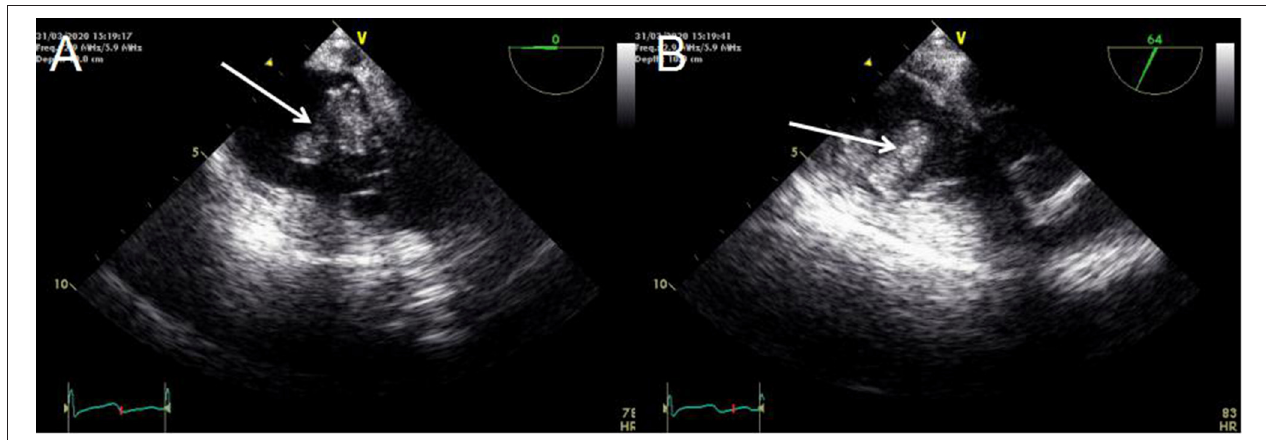
FIGURE 2 | (A,B) Transesophageal echocardiography showing lumpy vegetations in the tricuspid